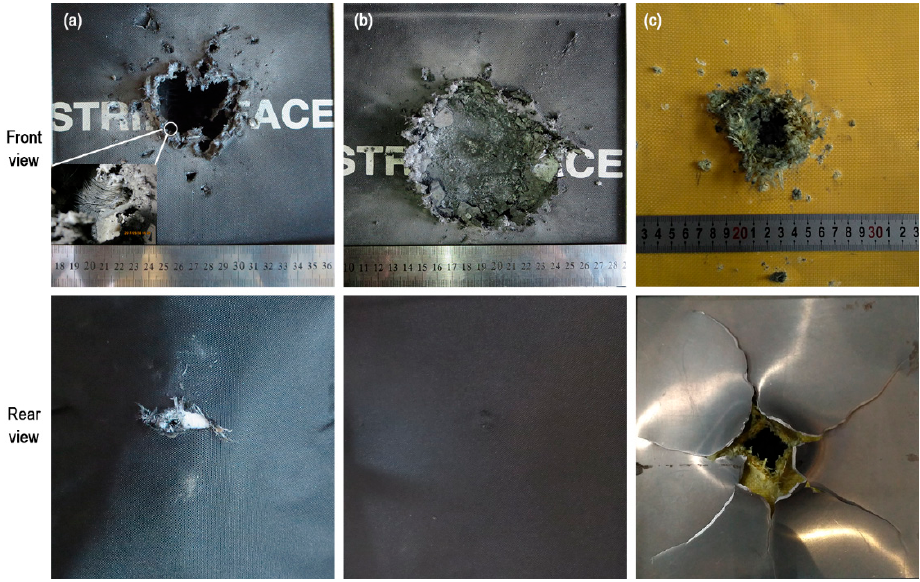
Figure 7. The experimental results of the rear walls (( a ) B-1; ( b ) B-2; ( c ) configuration C).